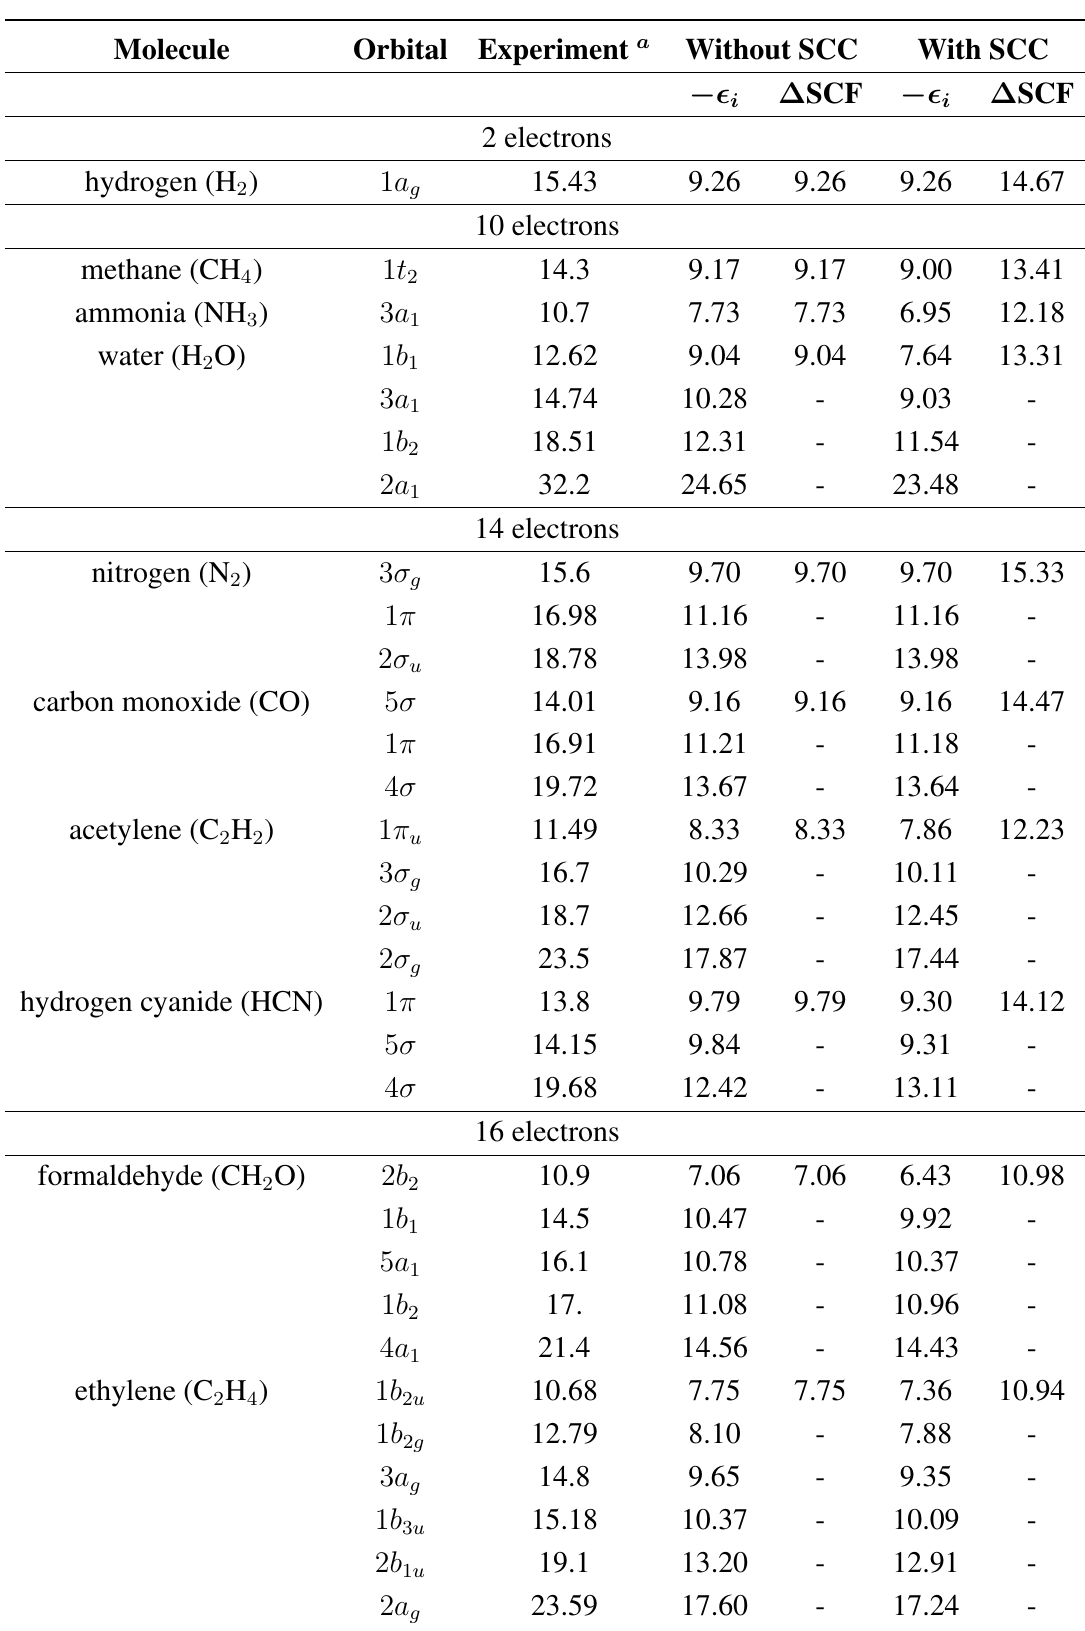
Table 1. DFTB+ ionization potentials (IPs) (eV) for small molecules. SCC, self-consistent charge. Molecule Orbital Experiment